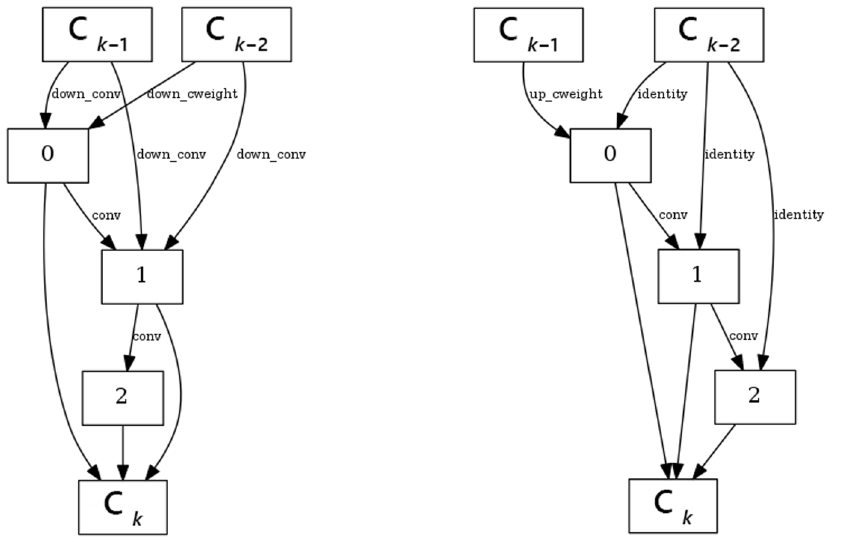
Figure 7. Visualization of NAS-MACU-V7 cell genotypes (DownSC ( left ) and UpSC ( right )) with three intermediate nodes.